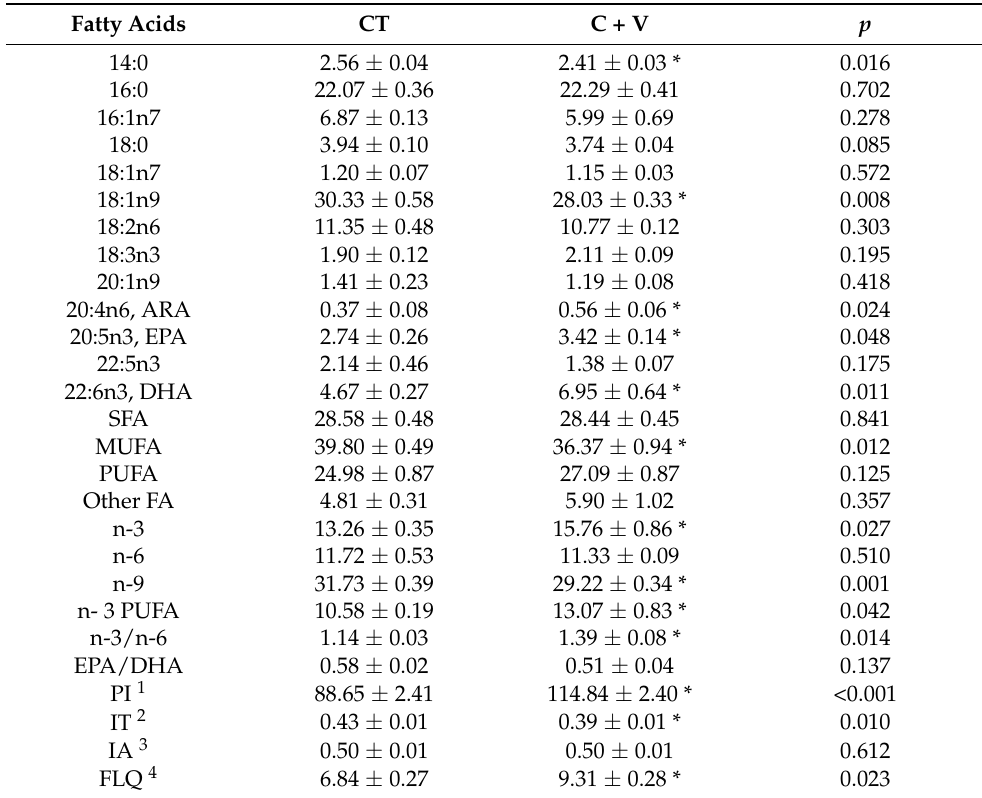
Table 5. Muscle fatty acid profiles (% of total fatty acids) of juvenile C. labrosus fed the control (CT) and C. fusca + V. proteolyticus (C + V) diets for 90